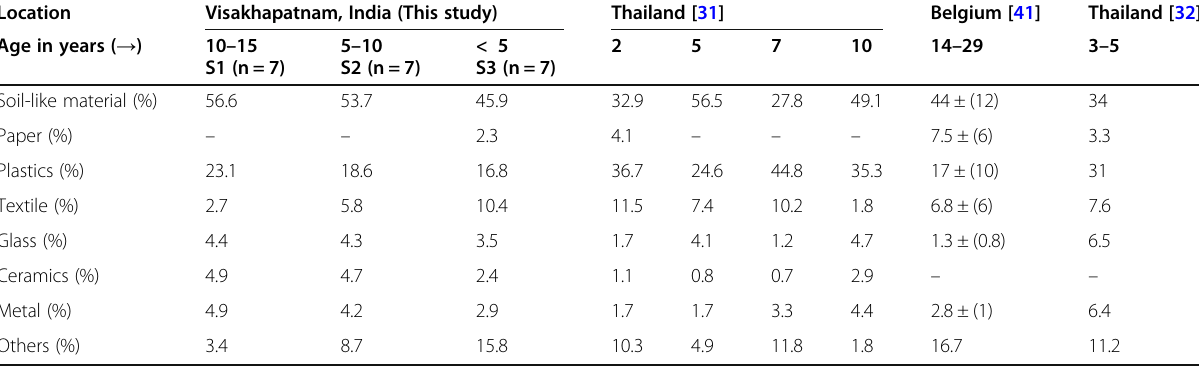
Table 2 Physical classification of the aged waste recovered (in %) from landfills